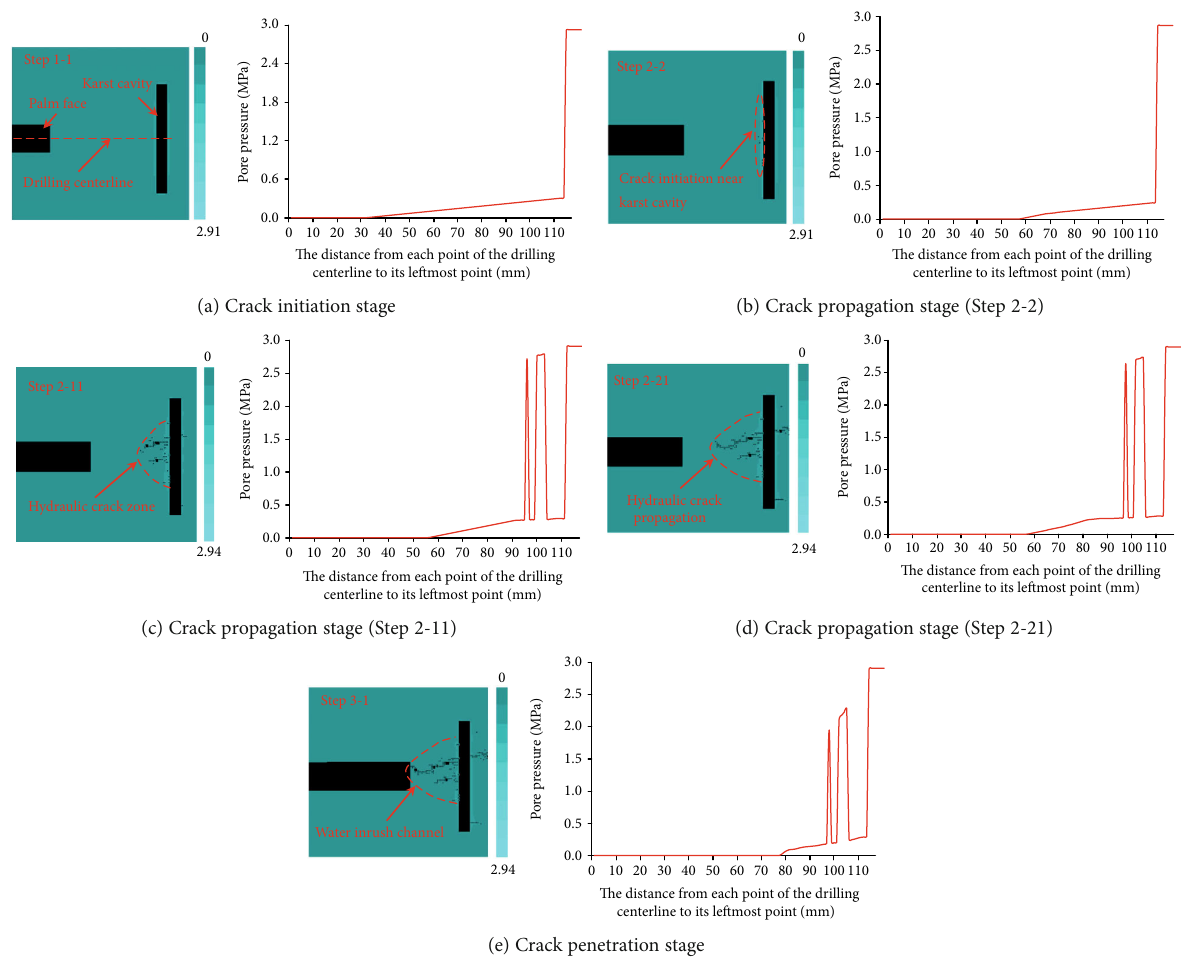
Figure 7: The pore water pressure